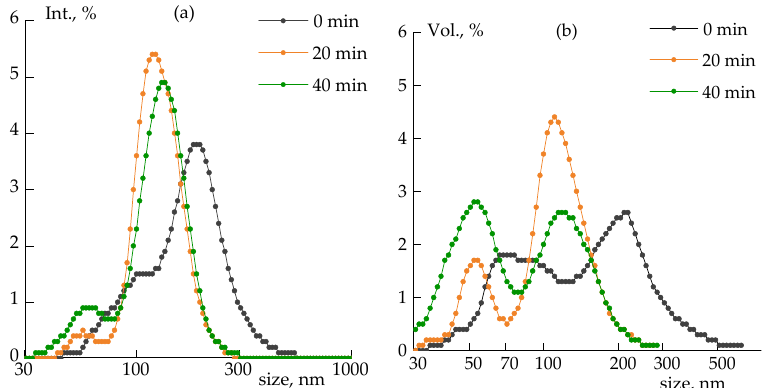
Figure 3. Size distribution of silica aggregates in DMSO in terms of scattered light intensity ( a ), and volume fraction ( b ) at the different sonication duration (indicated in plots).